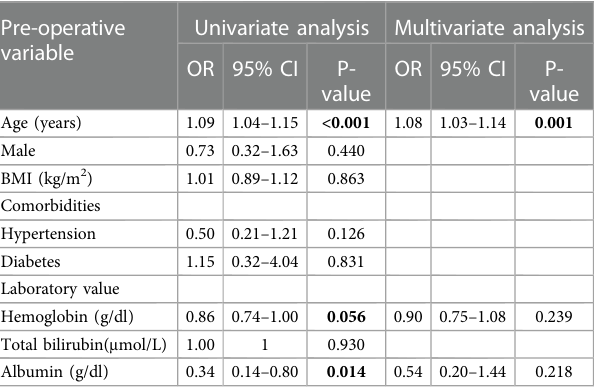
TABLE 2 Univariate and multivariate analyses of preoperative predictors associated with the occurrence of Clavien-Dindo Score ≥ 3b.